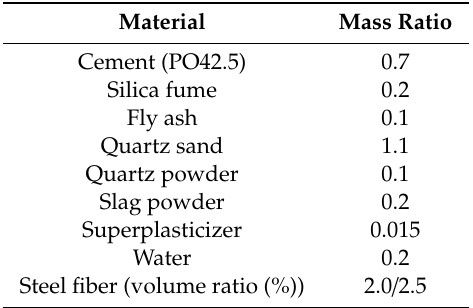
Table 1. UHPC Martials Proportion (in reference [25]).